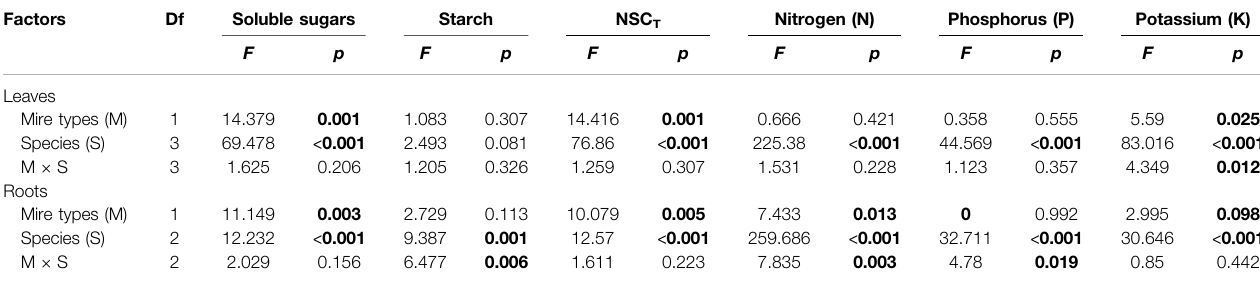
TABLE 2| Effects ofmire types, species, and their interactions onconcentrationsofNSCs (i.e.,sugars,starch,and NSC T ) and nutrients (i.e.,N, P,and K)inplant leaves and roots in August, tested with two-way nested ANOVAs. F and p values are given.